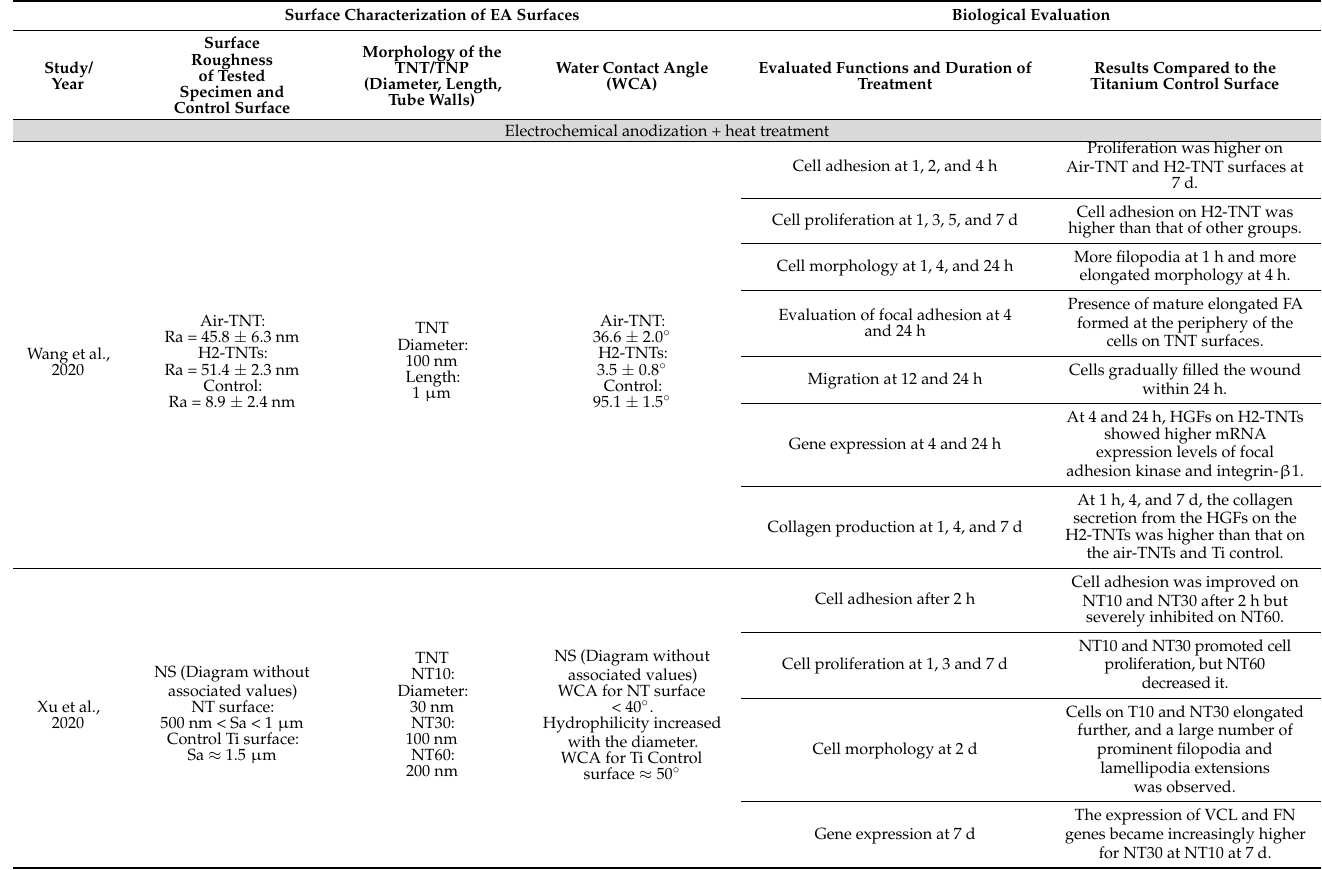
Table 4. Summary of the results of the studies reviewed on the basis of fabrication strategy. It was decided to keep the original names of the different groups in order to conform to the abbreviations chosen by the authors of the studies selected. Surface Characterization of EA Surfaces Biological